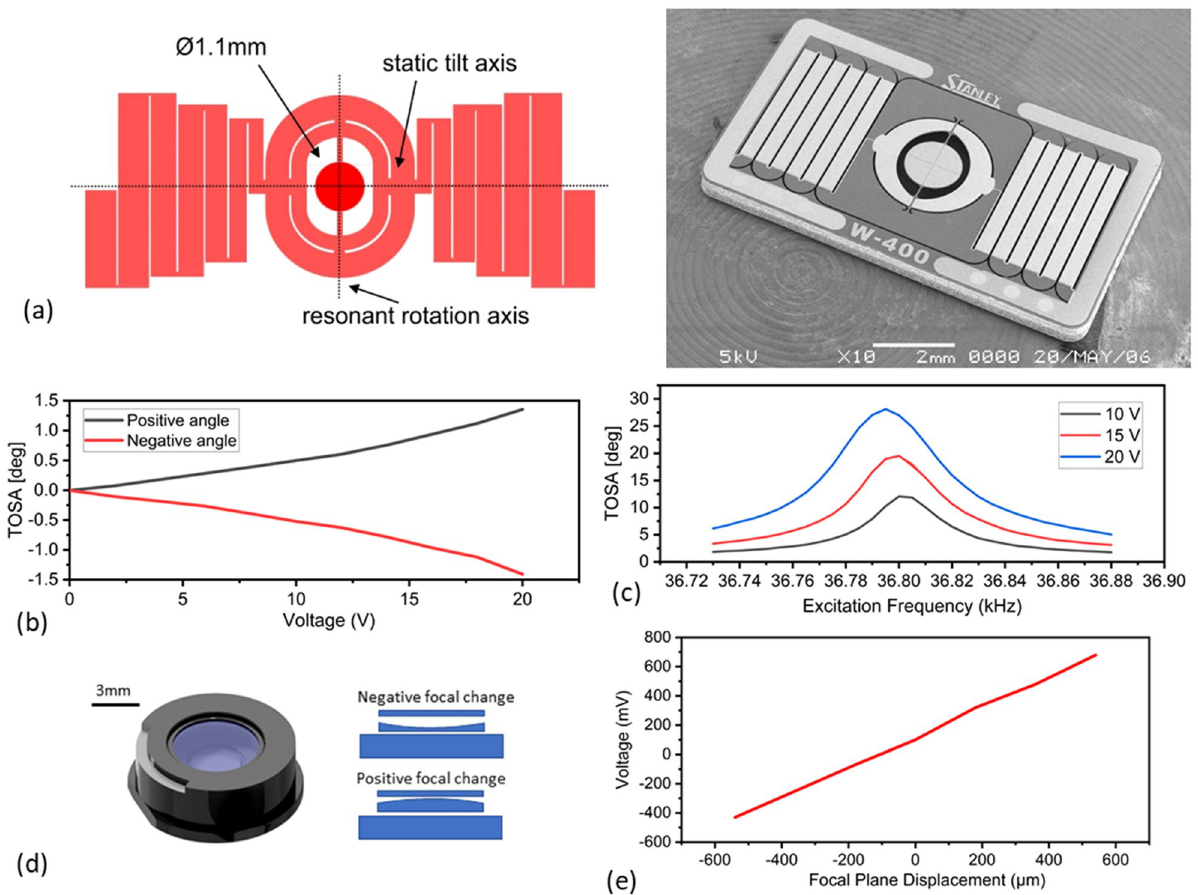
Figure 2. Characterisation of the optical MEMS devices. ( a ) Schematic and SEM Image of the 2D PZ scanning mirror featuring spiral actuators for static rotation and an inner ring frame for fast resonance rotation. ( b ) Total optical scan angles of static rotation (scan along z-axis) with voltage input up to 20 V (max) for positive and negative angles. ( c ) Total optical scan angle (TOSA) characteristics near the fast axis (scan along y-axis) resonance peak of 36.8 kHz for three different voltage inputs of 10 V, 15 V and 20 V (max). ( d ) Schematic and working principle of commercial MEMS tunable lens Optotune EL-3-10. ( e ) Tunable lens focal shift characteristic in the miniaturized LSM